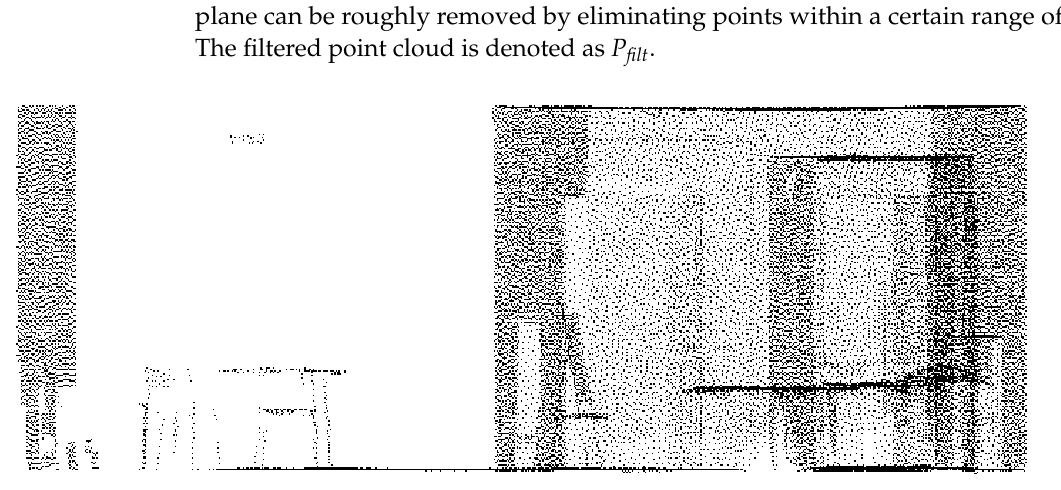
Figure 4. Front view of an indoor point cloud.